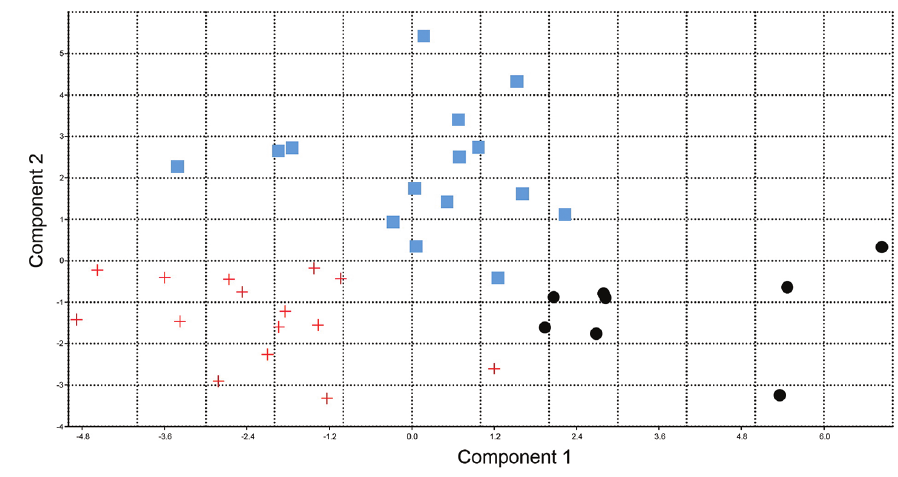
Figure 11. Principal component analysis of relative morphometric characters of the Capoeta razii sp. n. (+) C. fusca (•) and C. capoeta (  )